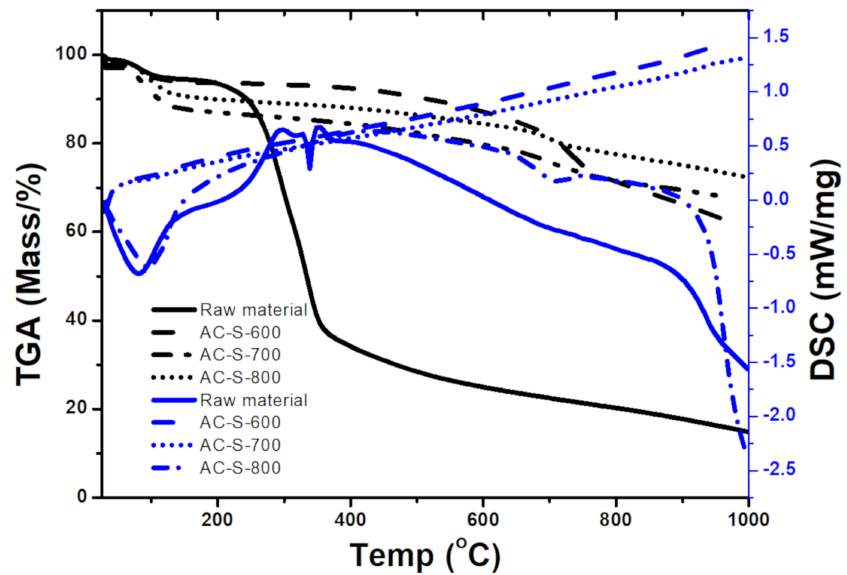
Figure 1. TGA-DSC analysis profile of African maize cobs (AMC) dried powder materials, AC-S-600, AC-S-700 and AC-S-800 activated